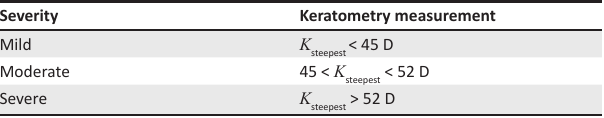
TABLE 1: Grading of keratoconus according to the Collaborative Longitudinal Evaluation of Keratoconus 13 method